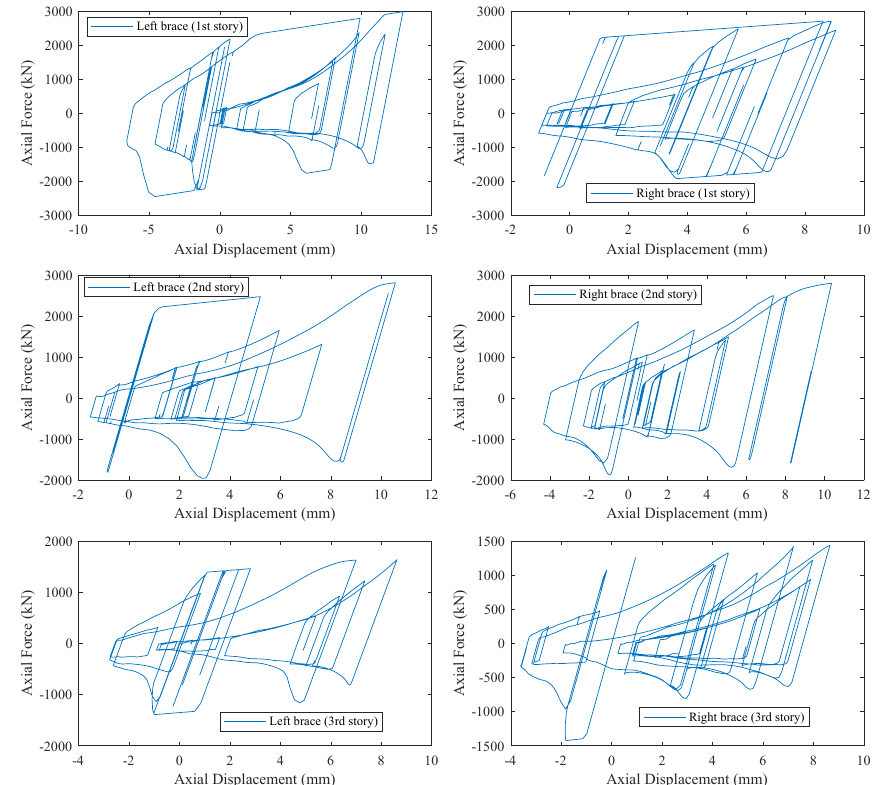
Figure 10. Axial force-axial displacement for the braces in the cross-braced frame.